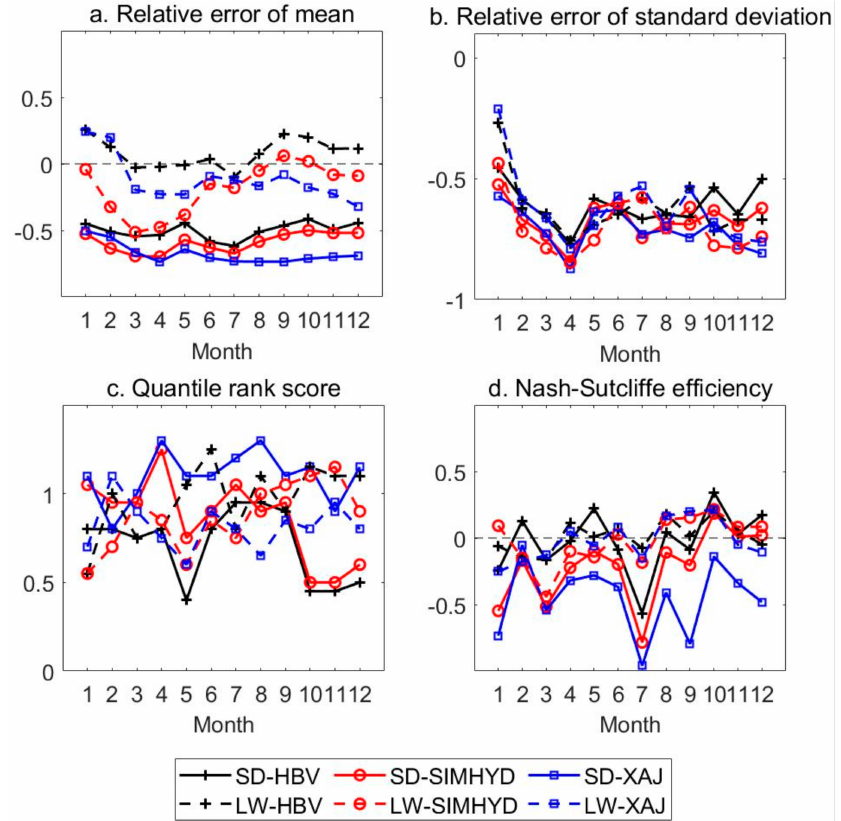
Figure 4. Performance of hydrological models in the baseline period driven by climate data derived from the SDSM and LARS-WG downscaling